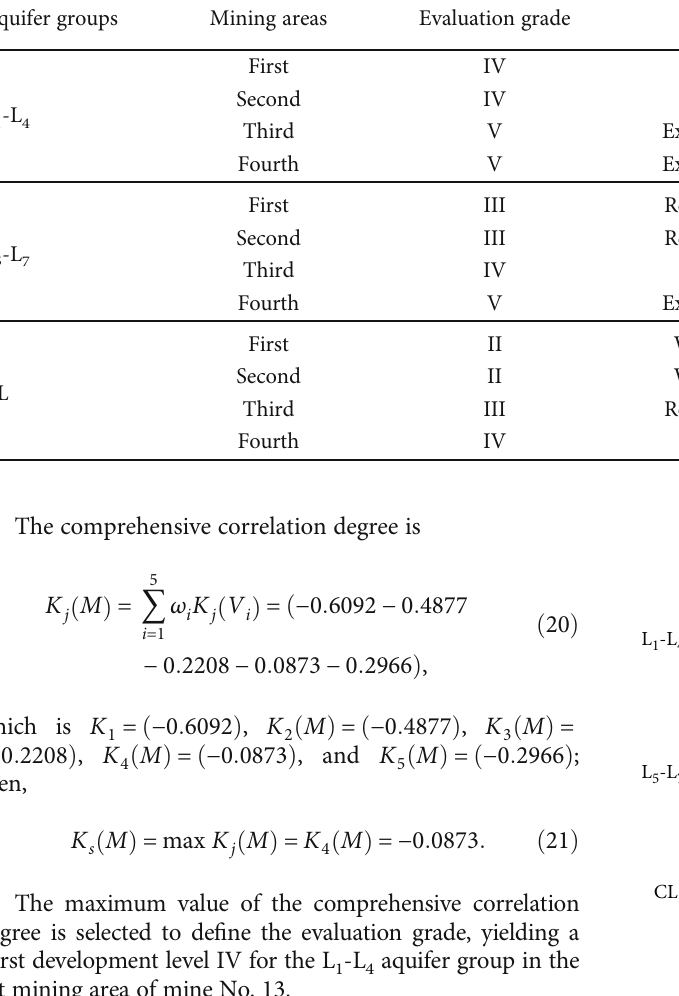
Figure 3: Diagrammatic drawing for quantitative evaluation of karst